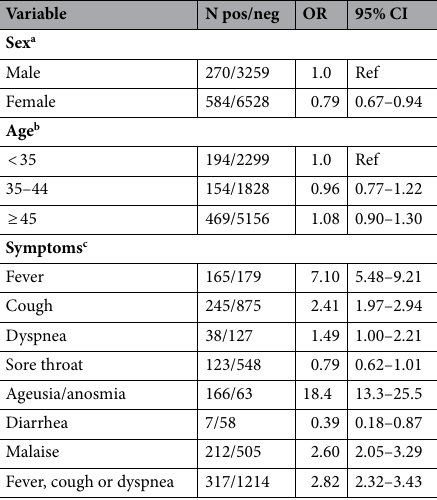
Table 4. Odds ratio of SARS-CoV-2 infection according to sex, age, and presence of symptoms. OR odds ratio, CI confidence interval, Ref reference category. a OR adjusted for age and center. b OR adjusted for sex and center. c Self-reported symptom at least one contact; OR adjusted for sex, age and center.